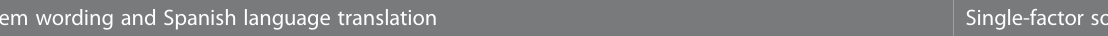
TABLE 2 Factor loadings and unique variances based on a principal components analysis (unrotated) for the 19 items of the DSAS-2 Spa-US (N=517). Item wording and Spanish language